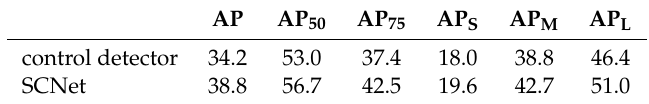
Table 3. Comparison of SCNet and control detector—evaluated on a COCO val